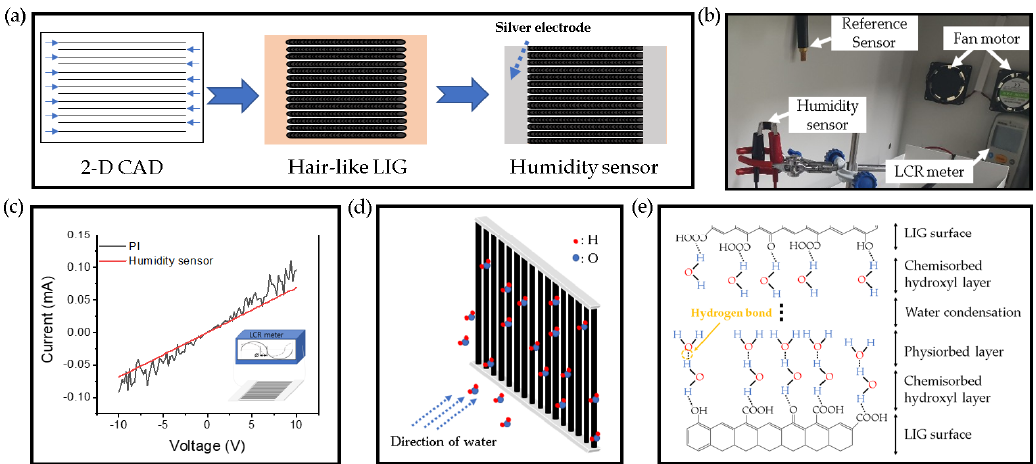
Figure 6. ( a ) Method for fabrication of a hair-like LIG humidity sensor, ( b ) photograph of the humidity measurement set-up, ( c ) I-V characteristics of the humidity sensor, ( d ) schematic illustration of a humidity sensor exposed to humidity, ( e ) absorption processes of water molecules by hydrogen bonding to the LIG surface after moisture